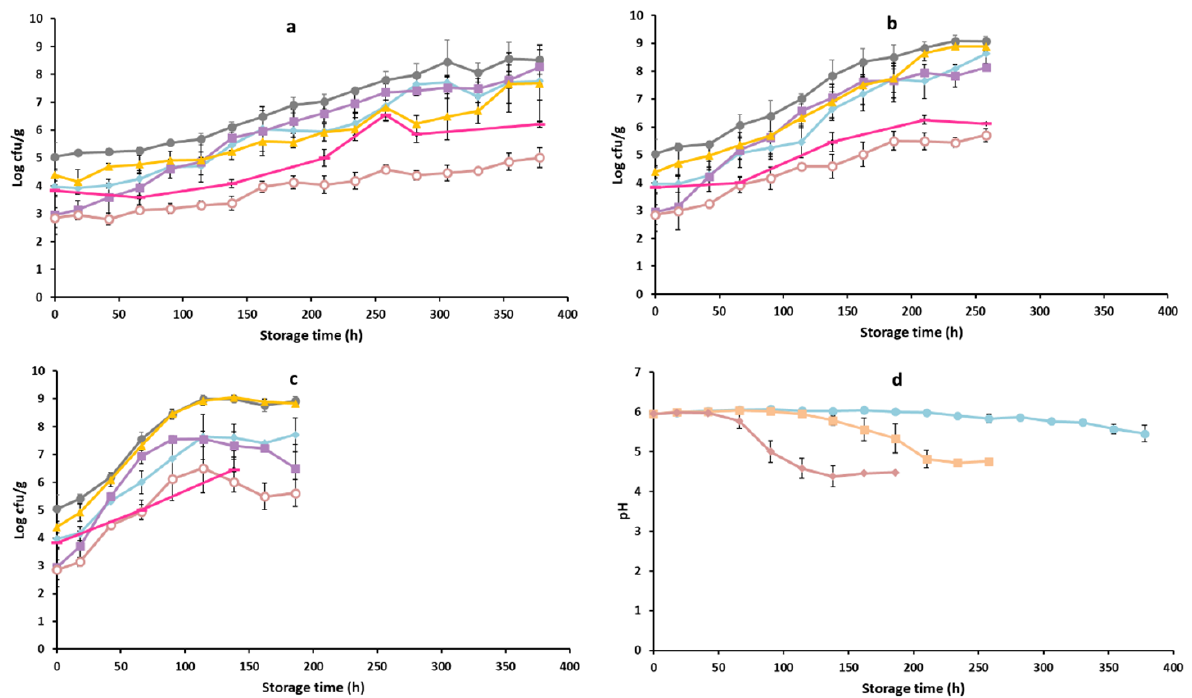
Figure 1. Populations (mean ± standard deviation, n = 4) of microbial groups of chicken burger during storage at 0 °C ( a ), 4 °C ( b ) and 8 °C ( c ) for batch 1 and 2; TVC (●), B. thermosphacta ( ■ ), Pseudomonas spp. ( ♦ ), LAB ( ▲ ), yeasts (–) and Enterobacteriaceae (o). pH values ( d ) of 0 °C (●), 4 °C ( ■ ) and 8 °C ( ♦ ).